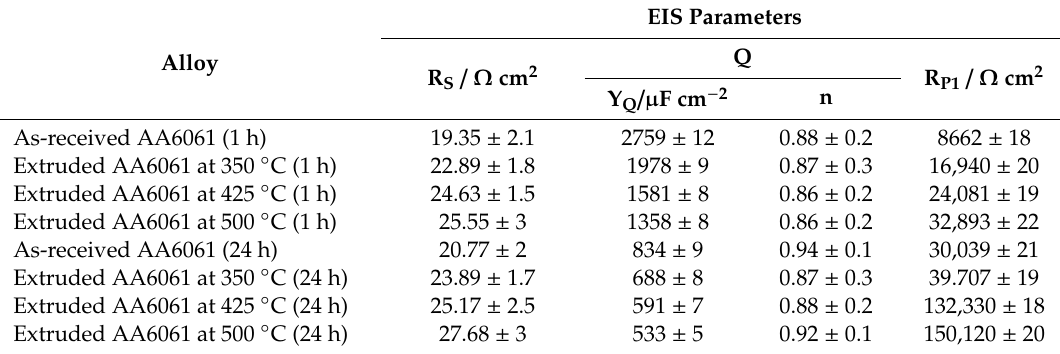
Table 2. EIS results of AA6061 alloys in chloride solutions.